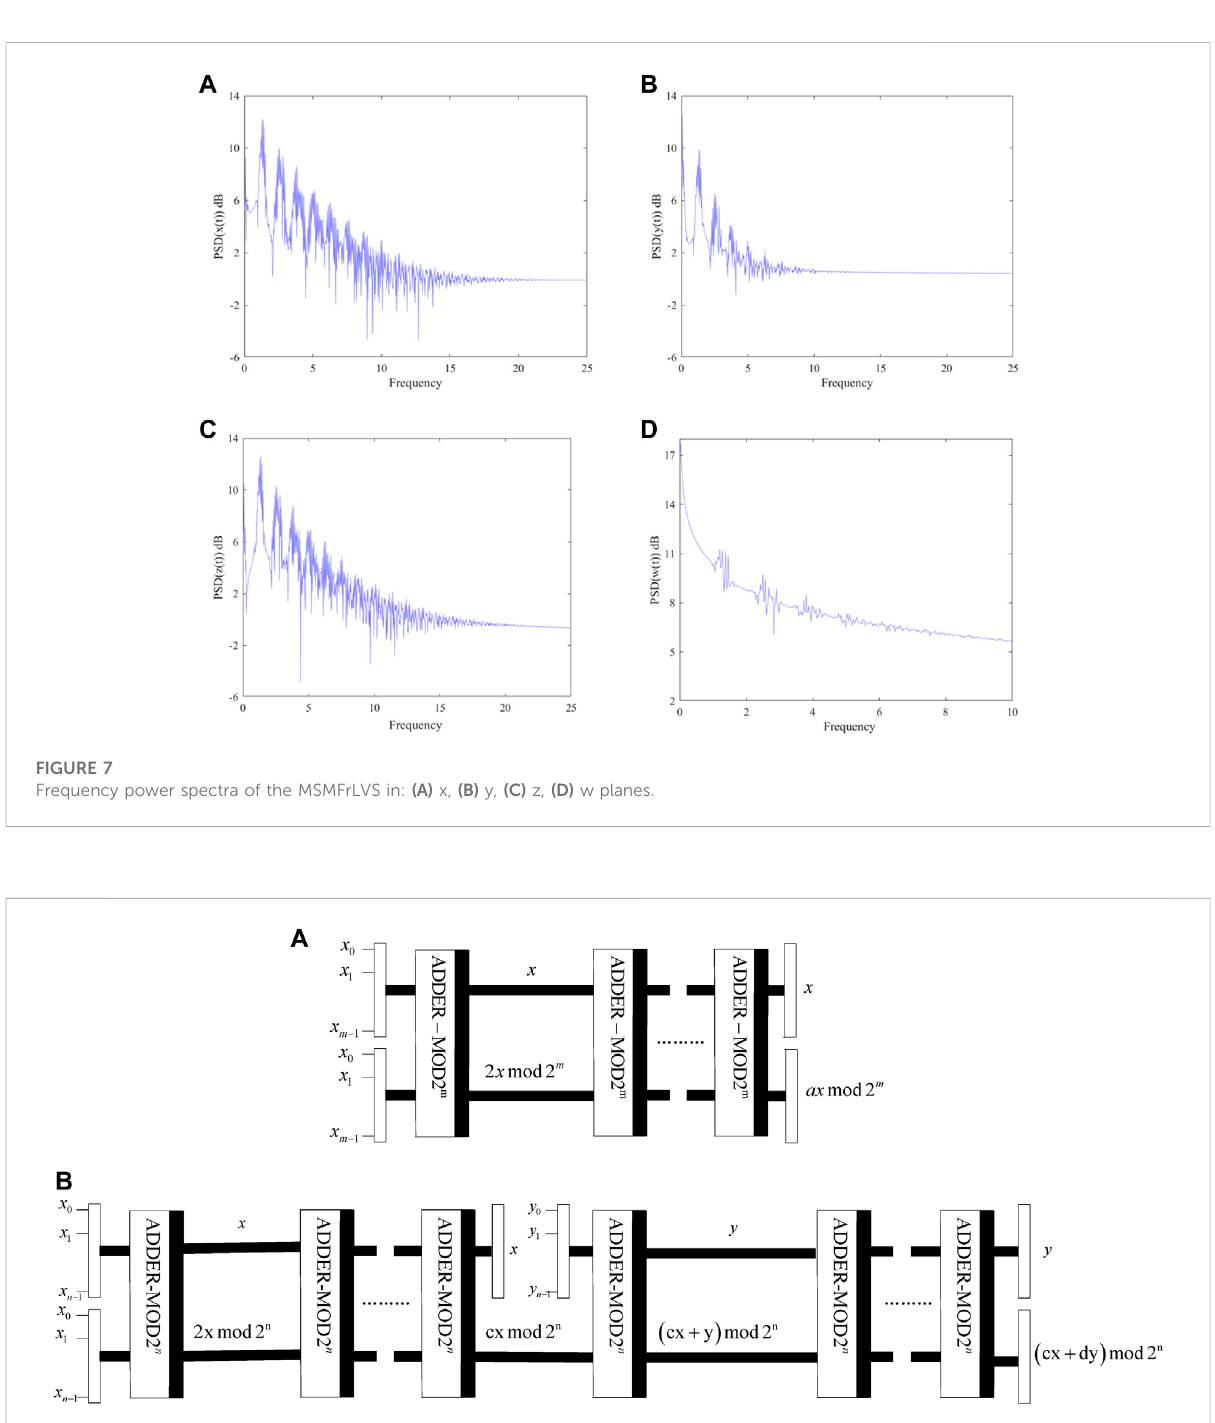
FIGURE 8 Quantum circuits: (A) | x ′ 〉 , (B) | y ′ 〉 .